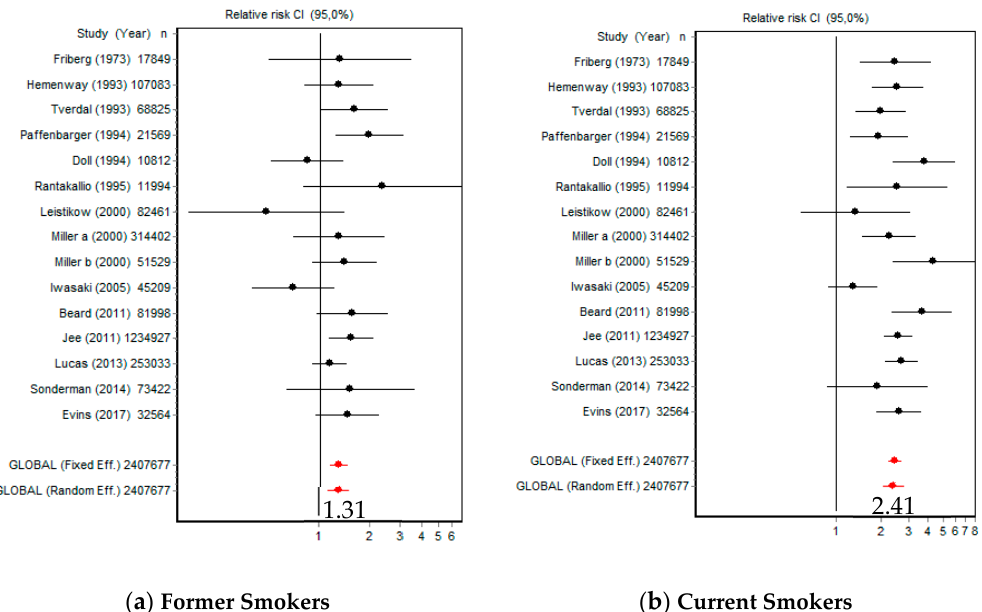
Figure 2. Forest plots of reported suicide rates in former and current smokers. Compared with NS, the risk of death by suicide for CS women was 2.51 (95% CI [2.06, 3.04]) and 2.06 (95% CI [1.62, 2.62]) for CS men (Figure 3). Women were significantly more at risk than men ( Q = 13,591.53; p < 0.001); in women Q = 2.00 ( p = 0.848) and in men Q = 21.54 ( p =